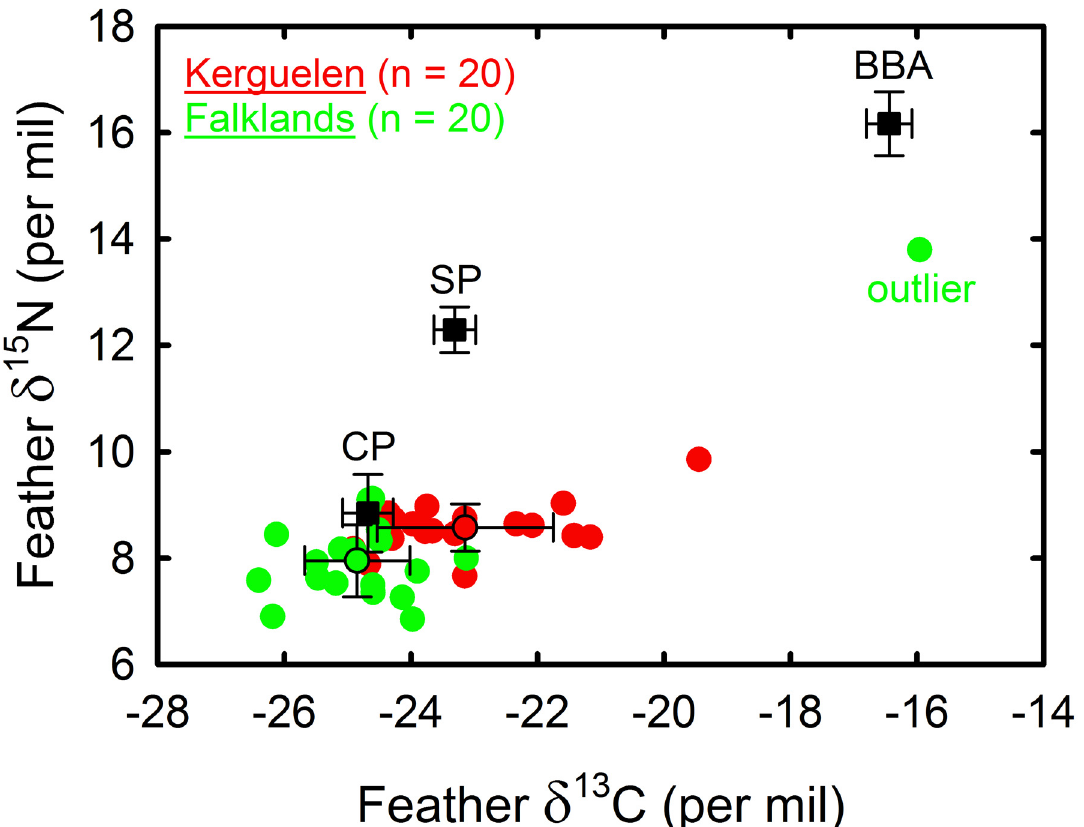
Fig 4. Stable isotope analyses of thin-billed prions from the Falkland and Kerguelen Islands. Feather δ 13 C and δ 15 N values of thin-billed prions from the Falklands (green) and Kerguelen Islands (red) grown in the nonbreeding area in 2010 and 2012, respectively (N = 20 per year). Note one thin-billed prion from the Falklands with very high stable isotope values (marked “ outlier ” ). This bird did not migrate, but spent the whole nonbreeding season on the Patagonian Shelf. The signature of chick feathers of cape petrel (CP) and snow petrel (SP) from Adélie Land illustrate the δ 13 C values of species known to forage in high-Antarctic waters where they feed primarily on crustaceans and fish, respectively [53], authors ’ unpublished data); the signature of chick down of black-browed albatross from New Island refers to a species that forage over the Patagonian shelf and feed on high trophic level prey [54,